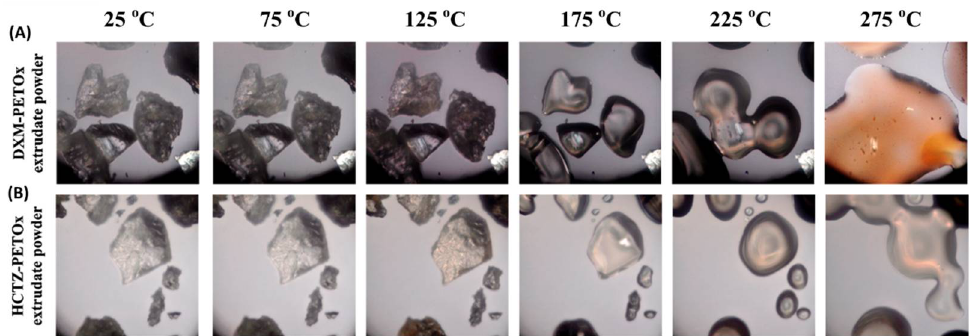
Figure 2. Hot-stage microscopy of powdered samples of ( A ) DXM extrudates and ( B ) HCTZ extru-